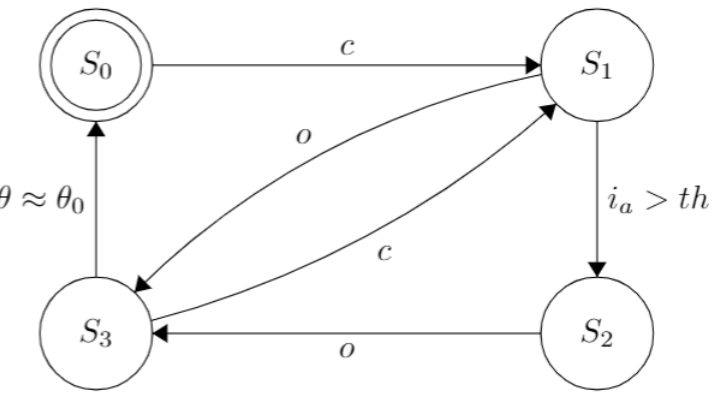
Figure 3. Finite State Machine demonstrating the opening/closing behavior of each finger on the prosthesis. S 0 indicates that the finger is entirely open; S 1 , represents the flexion process triggered by the command c ; S 2 , indicates the finger is completely open (since i a > th ). Additionally, S 3 represents the extension process triggered by command o until θ ≈ θ 0